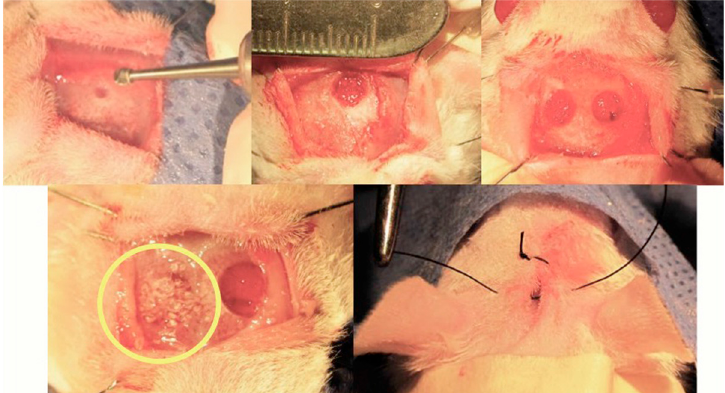
Figure 10. Implementation of the cranial defect model and construct (circle) transplantation. Process reported in Martín-del-Campo et al. [16].